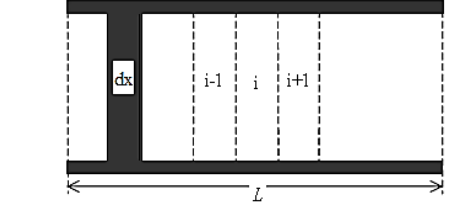
Figure 6. Pattern of flow in a slot.